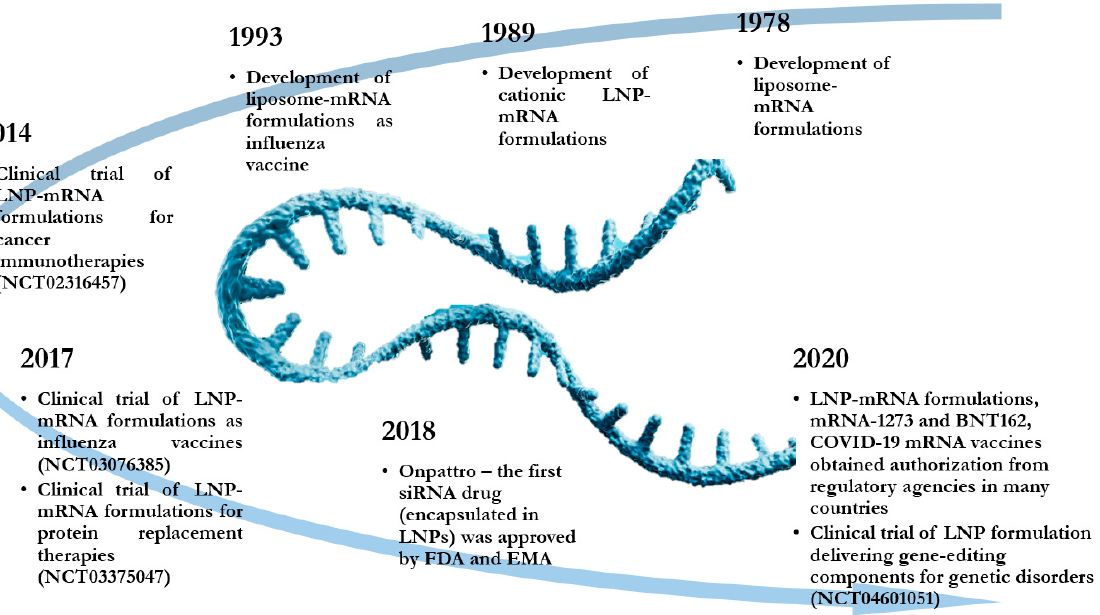
Figure 1. Most important benchmarks in the development of lipid-based delivery systems for RNA. Adapted from